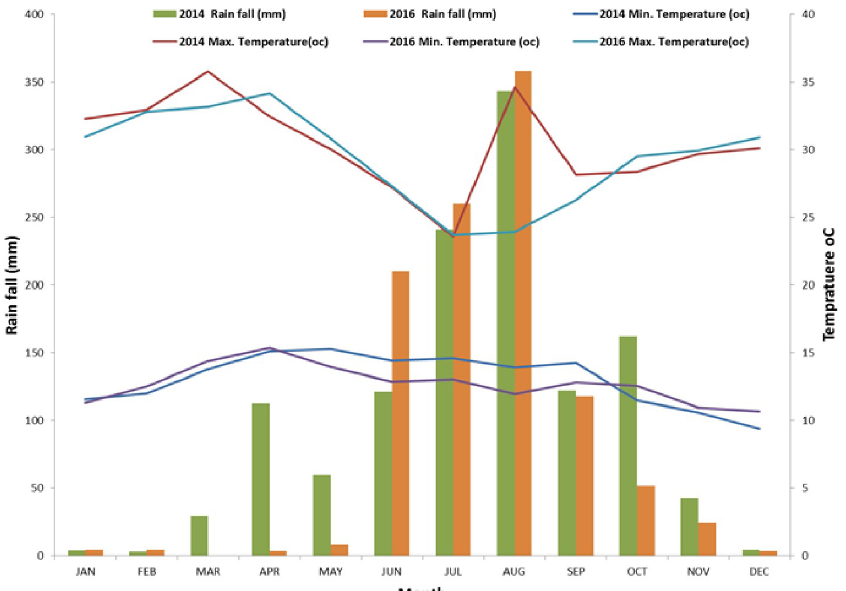
Fig 2. Mean monthly rainfall and temperature distribution in the two experimental years (2014 and 2016) at